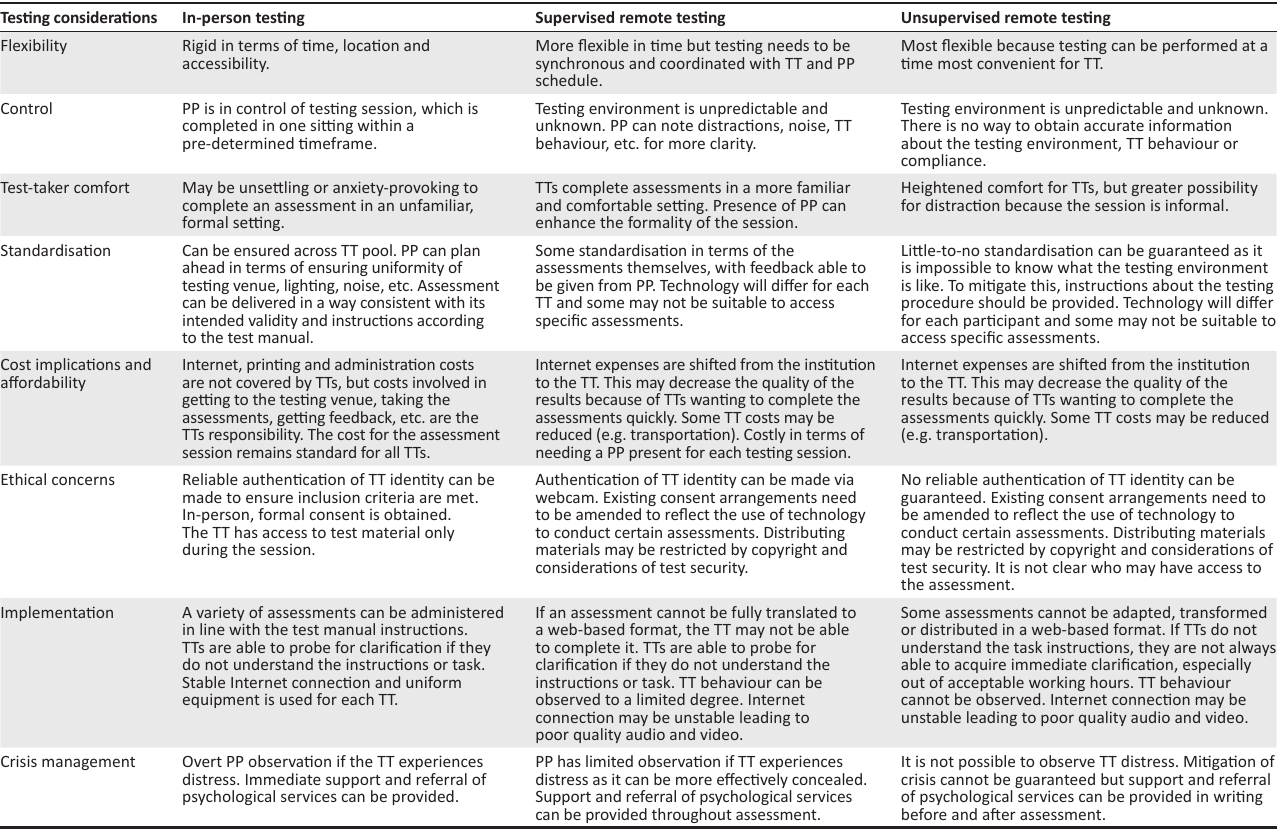
TABLE 1: Considerations for in-person, supervised and unsupervised remote